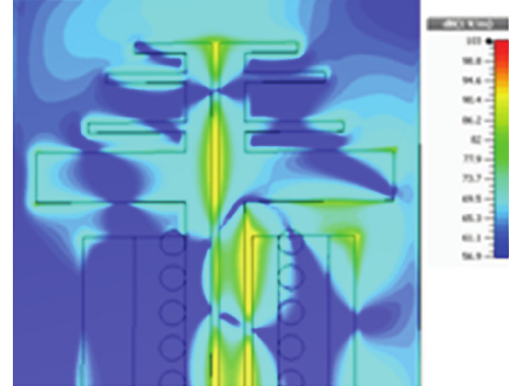
Figure 3: Simulated electric field density distributions of the proposed antenna (35 GHz).